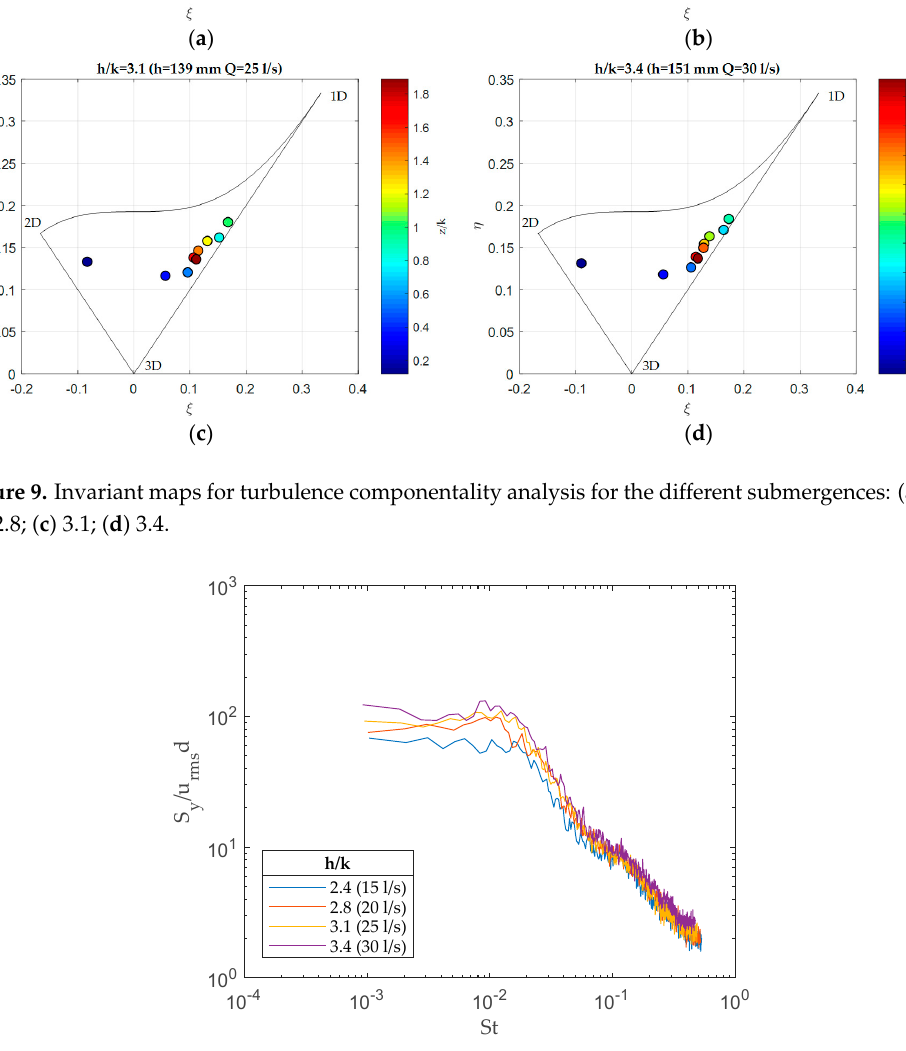
Figure 11. Turbulence triangle for the smooth bed case ( Re h = 13,680) (from [25]). Although the two plots refer to flows with different Reynolds numbers (13,680 and 75,000 for the smooth and uniformly vegetated beds, respectively), the comparison allows the main differences in terms of the turbulence anisotropy pattern to be seen. While in the viscous sublayer, directly above the flume bed, a two-component isotropic turbulence was expected for both the conditions; at (cid:1878) / (cid:1863) = 0.1 ( (cid:1878) / ℎ ≈ 0.04) the behavior was different and the turbulence in the vegetated case presented a 2D structure. On the contrary, in the smooth bed, as expected for a canonical boundary layer, the